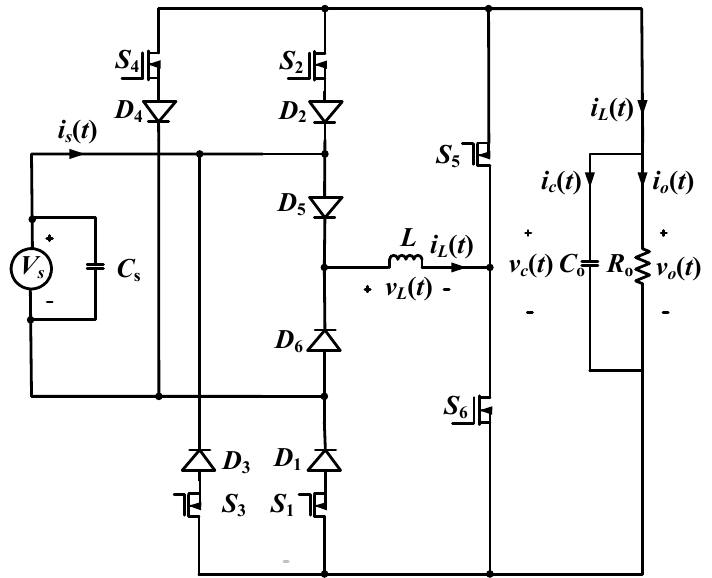
Figure 1. Conventional symmetrical bipolar voltage gain converter.